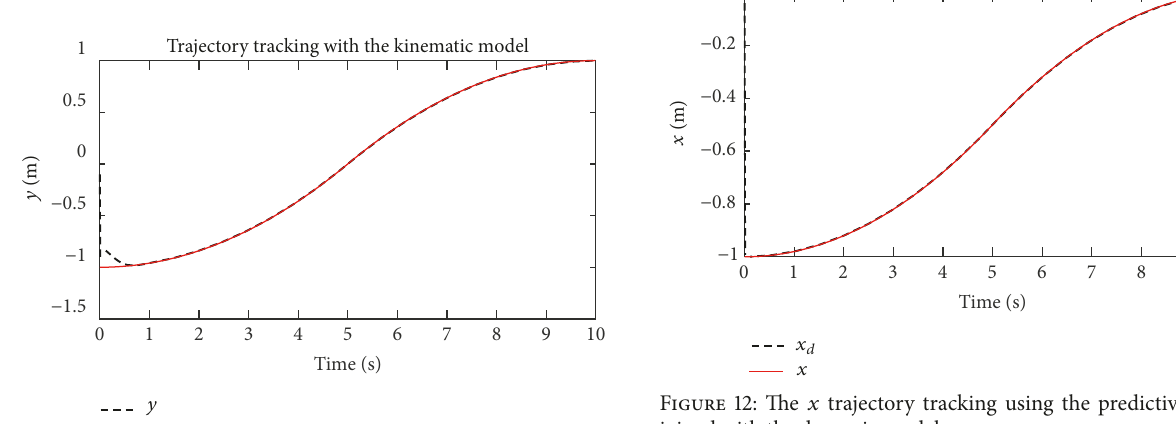
Figure 8: The 𝑥 trajectory tracking using the predictive control joined with the kinematic model.